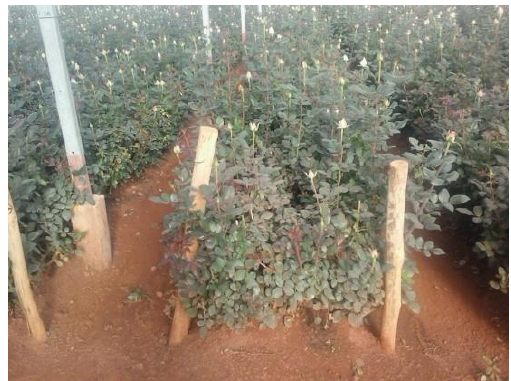
Figure A1. A picture of rose plants growing directly on slightly raised soil beds in a greenhouse. The vegetative bending forms a base from which upright shoots grow to stems, and are harvested as cut flowers (the picture taken by Kimani M. David, on 10 November 2013 in Kenya) .